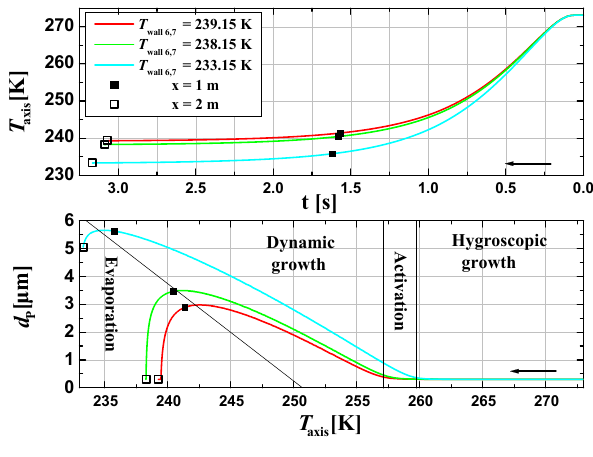
Fig. 3. Both panels : FLUENT/FPM model simulations for three different wall temperatures (233.15K, 238.15K and 239.15K). The black and the open square represent the end of the first and second freezing section. The curves are traced from right to left as particles cool monotonically while moving along the axis of the LACIS flow tube. Upper panel : Simulations of the axial temperature profile the particle beam is exposed to as function of residence time inside LACIS. Lower Panel : Simulations of the droplet growth behavior inside the two freezing sections. T axis is the temperature which the particles experience in the particle